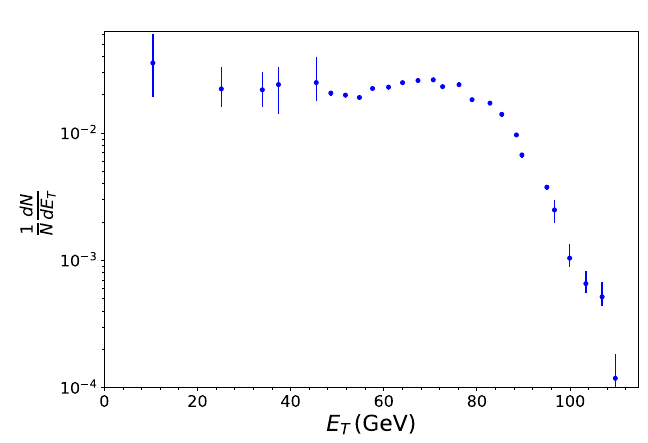
√ s = 200 GeV per nucleon in pseudorapidity NN